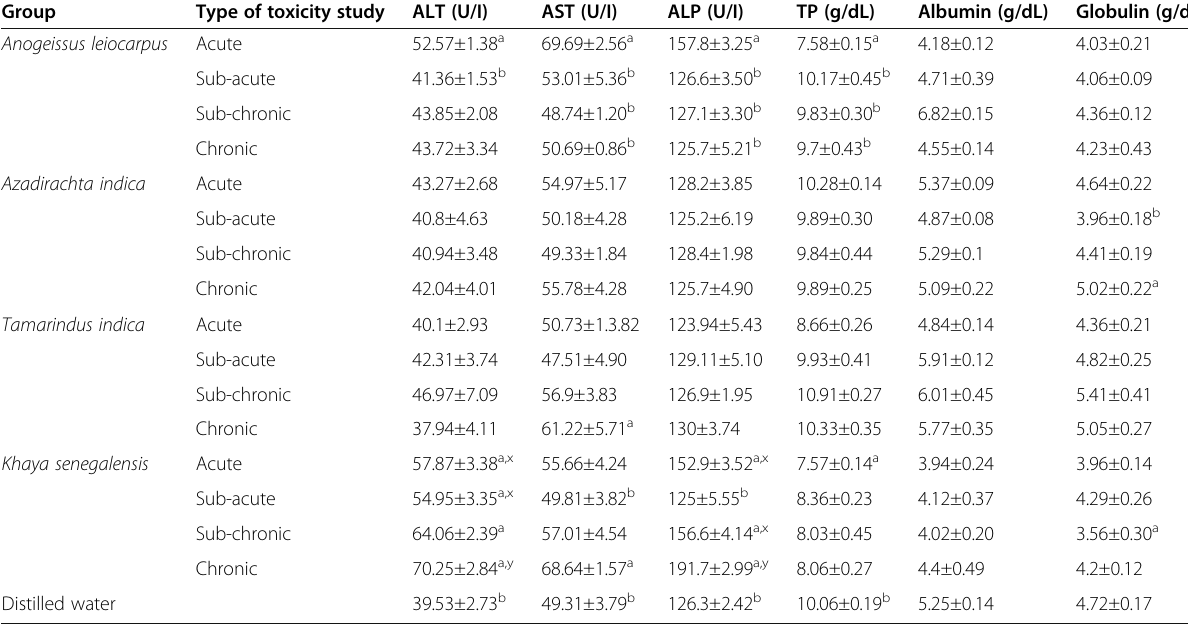
Table 4 Liver function test of rats subjected to short, medium and long term oral administration of extracts of four ethnomedicinal plants